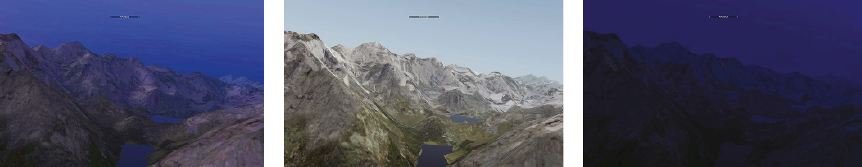
value is mapped to a higher value. A bias( x ) value less than mean = 0.5 shifts the straight-line portion of the inverse hyperbolic tangent toward lower levels of light. Figure 11(a) illustrates these relationships where gain( x ) = 0 . 5. Similarly, a family of inverse hyperbolic tangent remapping curves can be generated by having the bias( x ) parameter fixed such as at mean = 0.5 and varying the gain( x ) parameter as shown